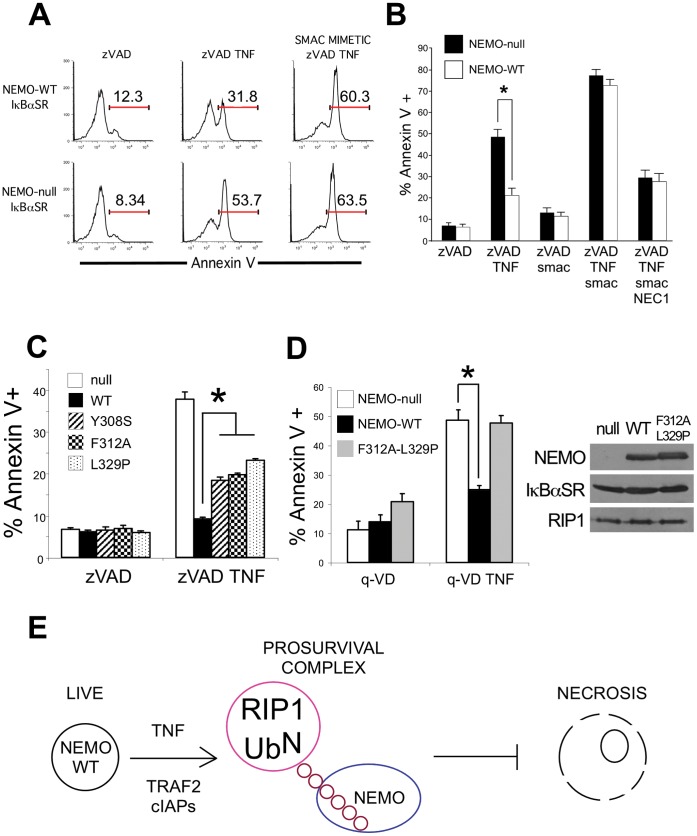
NEMO must be able to bind ubiquitin chains in order to prevent programmed necrosis.(A) NEMO-null cells expressing IκBαSR were transduced with retrovirus encoding a control protein or NEMO-WT. Cells were pre-treated for one hour with 10 µM zVAD with or without 100 nM SMAC mimetic and then stimulated with 10 ng/ml TNF for 24 h. Cell death was quantified by Annexin V staining and flow cytometry. The number above the gate indicates the percentage of cells that display Annexin V staining in one set of histograms representative of several experiments. (B) The bar chart shows the mean percentage of Annexin V staining cells and SEM from three independent experiments, in this case cells were co-incubated with 30 µM Necrostatin-1 to confirm that the cell death is RIP1 kinase-dependent programmed necrosis. (C) NEMO-null cells were reconstituted with retrovirus encoding NEMO-WT or the NOA/UBAN point mutants NEMO-Y308S, NEMO-F312A or NEMO-L329P, which are unable to bind ubiquitinated RIP1 upon ligation of TNFR1. The mean percentage and SEM of cells that stain with Annexin V after 24 h of 10 ng/ml TNF treatment in the presence of 10 µM zVAD is shown, * denotes p<0.05. (D) NEMO-null cells expressing the IκBαSR were reconstituted with NEMO-WT or NEMO-F312A-L329P, a double point mutation in the ubiquitin-binding domain of NEMO. The mean percentage and SEM of cells staining with Annexin V is shown for three independent experiments with cells co-incubated with the caspase inhibitor q-VD and 10 ng/ml TNF for 24 h, * denotes p<0.05. The immunoblot demonstrates that equivalent amounts of NEMO-WT and NEMO-F312A-L329P protein are expressed. (E) These data demonstrate that cells preferentially undergo apoptosis when NEMO cannot bind ubiquitinated RIP1 and that caspase inhibition is required for these cells to switch to RIP1 kinase-dependent programmed necrosis.